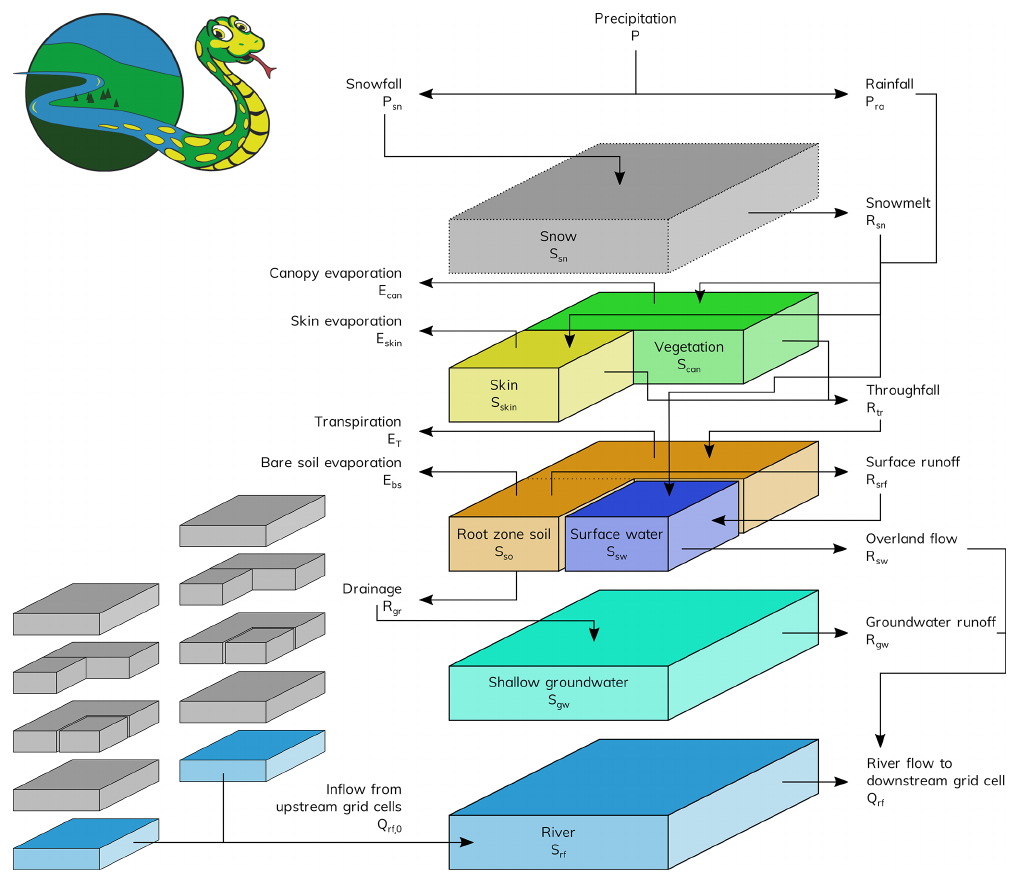
Figure 1. Schematic of the major water storages and fluxes in HydroPy together with the symbols used in the process description (see Sect. 2.2). Most processes only affect each grid cell individually (central column), but river routing also interacts with neighbouring cells (represented by small storage columns). The upper left corner shows the official logo designed for the HydroPy